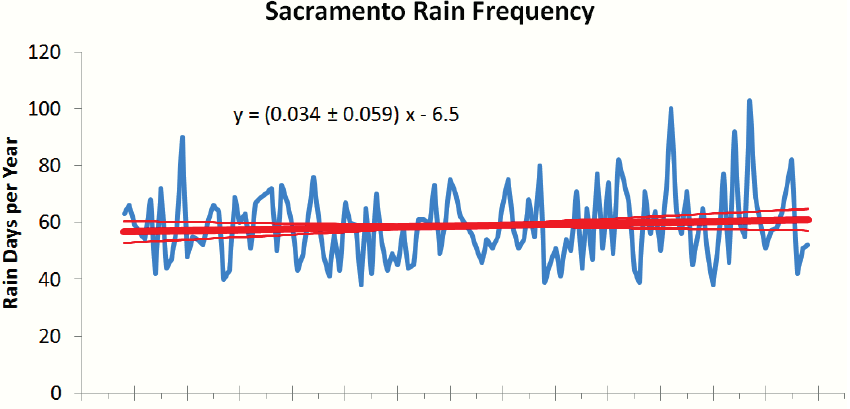
Figure 6. Number of days with measurable rain. Units of the slope in the trend equation are (number of rain days per year)/year. Neither record contains a significant trend in the frequency of